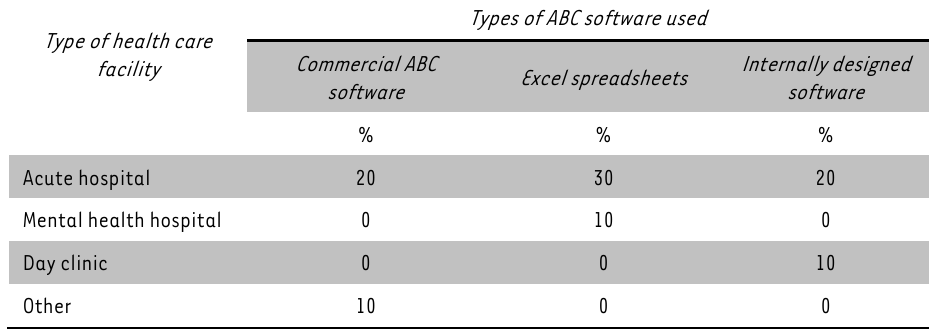
Types of ABC software used